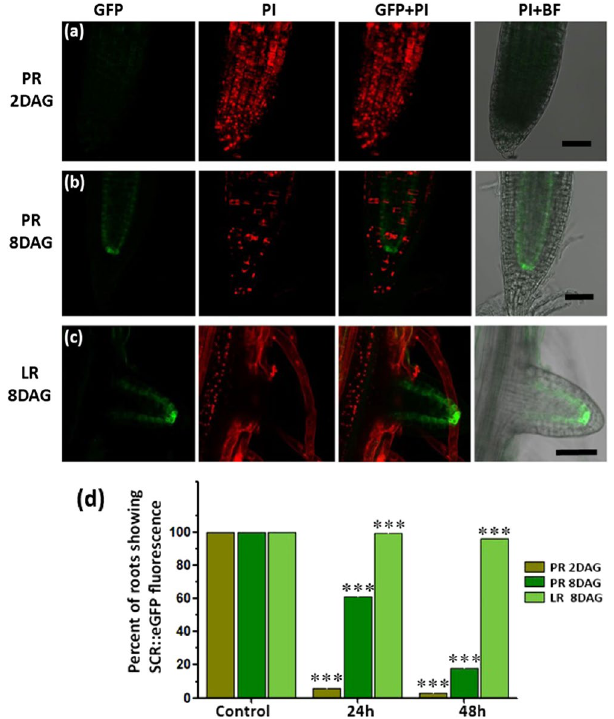
Figure 3. Age dependent salt sensitivity of the PR. 2 days after germination (DAG) PR is more sensitive to salt stress compare to LR of 8DAG. The SCR::GFP Arabidopsis plants of 2 and 8 DAG were subjected to lethal salt stress. Shown are the representative confocal images of PR of ( a ) 2 DAG plants that were salt treated for 24 h with no SCR::GFP fluorescence but ample of PI labelled nuclei indicating complete death of PR. ( b ) PR of 8 DAG SCR::GFP plants that were salt treated for 24 h, with SCR specific endodermal GFP expression and few PI labelled nuclei indicating induction of cell death processes. ( c ) Young LR (shorter than 100 µ m) of 8 DAG SCR plants that were salt treated for 24 h, with clear SCR specific endodermal GFP expression, without any PI labelled nuclei. Note in ( c ) the presence of PI labelled nuclei at the PR site of LR emergence, indicating death of the PR cells at that position and the viability of the complete LR which was PI negative. ( d ) Quantification of percent of roots showing SCR::GFP fluorescence in PR or LR after 24 h and 48 h of lethal salt stress. Asterisk ( *** ) above the bar in graph indicate statistical significance determined by pairwise Student’s t-tests ( α = 0.05). The scale bars = 50 µ m. The presented fluorescent images were projected at maximum intensity. The complete Z-stack images are provided in Figs.